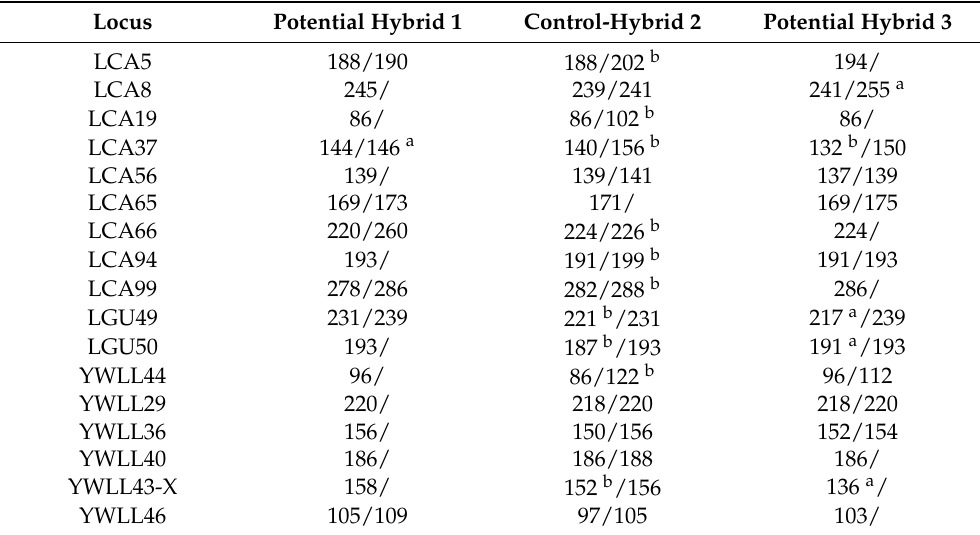
Table 3. DNA profiles of the hybrid and putative hybrids. a , alleles found only in llamas; b , alleles found only in alpacas. Locus Potential Hybrid 1 Control-Hybrid